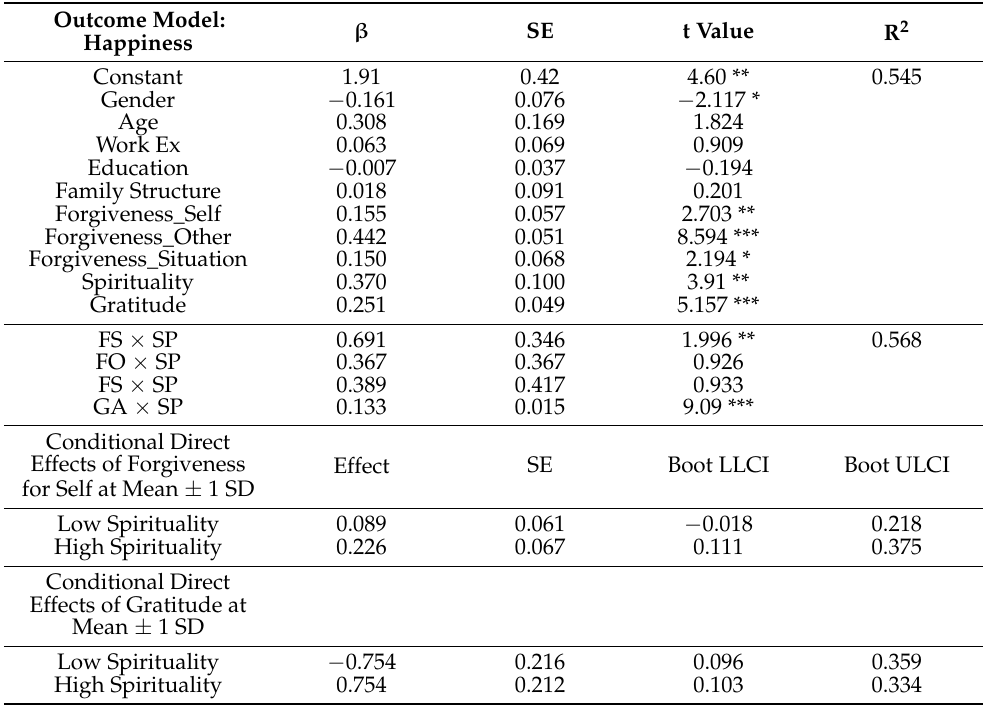
Table 4. PROCESS results for moderation hypotheses 1 and 2 using time 2